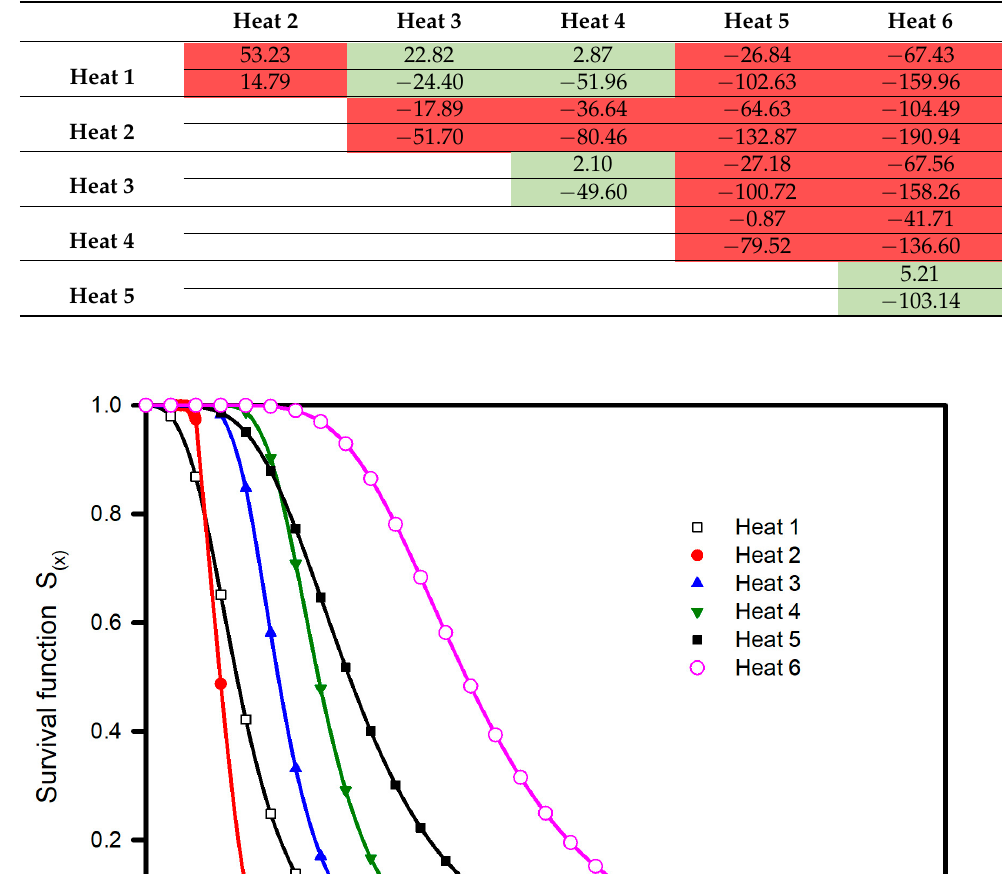
Table 4. Range of bounds of 95% confidence interval C.I.